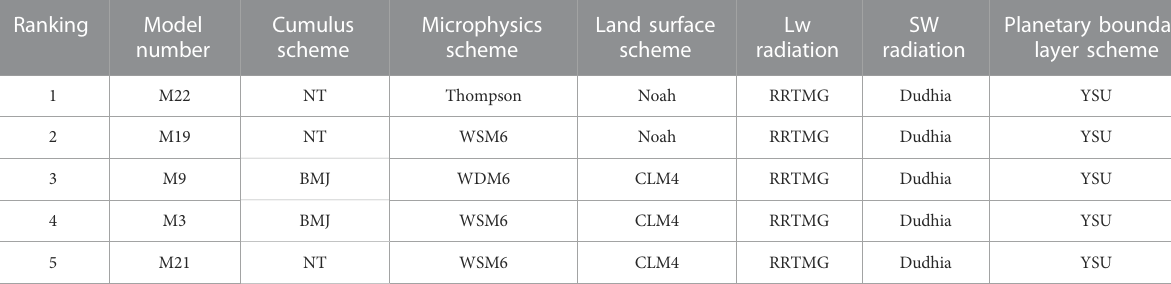
TABLE 6 Optimal combinations of WRF physical